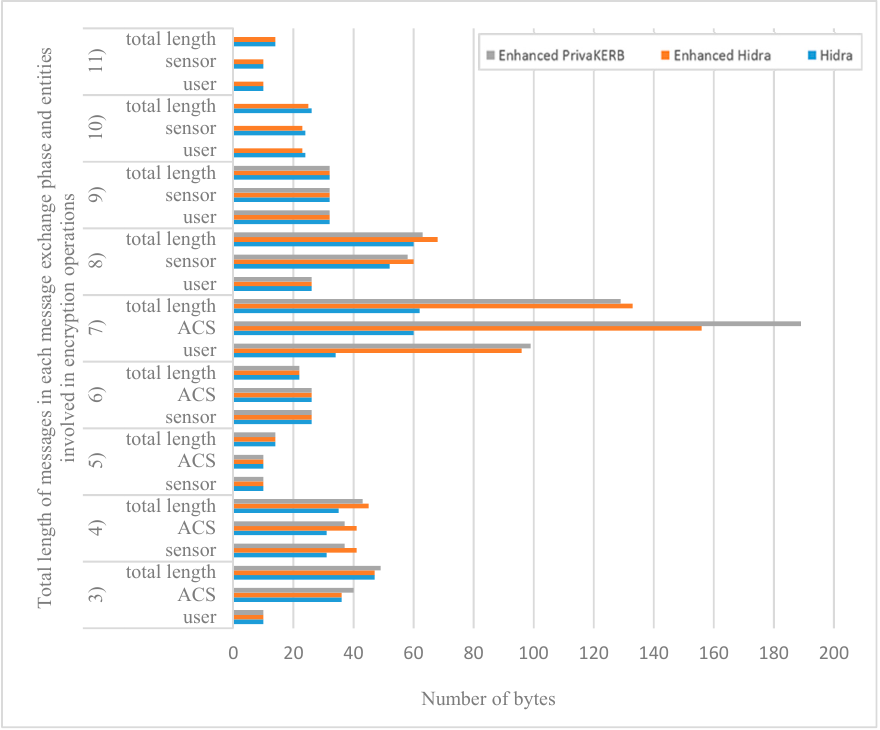
Figure 9. Comparison among enhanced PrivaKERB protocol, Hidra protocol, and enhanced Hidra protocol in the total length of messages and the number of bytes over which each entity must perform cryptographic operations.